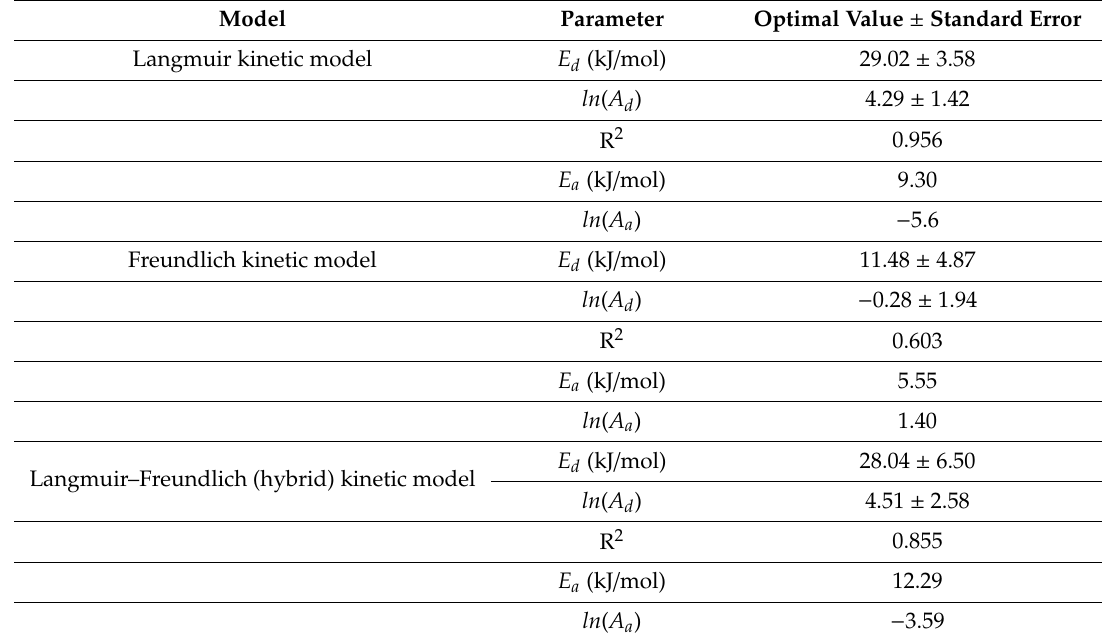
Table 6. Kinetic parameters for the MB sorption onto